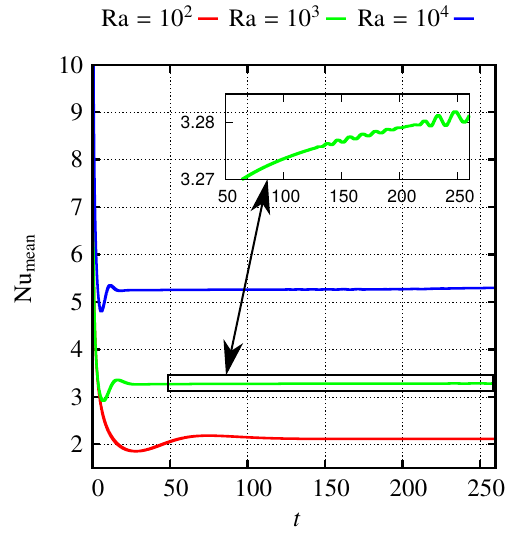
Fig. 9. Temporal evolution of mean Nusselt number Nu mean for various values of Ra. Rescaled detail for Ra = 10 3 .